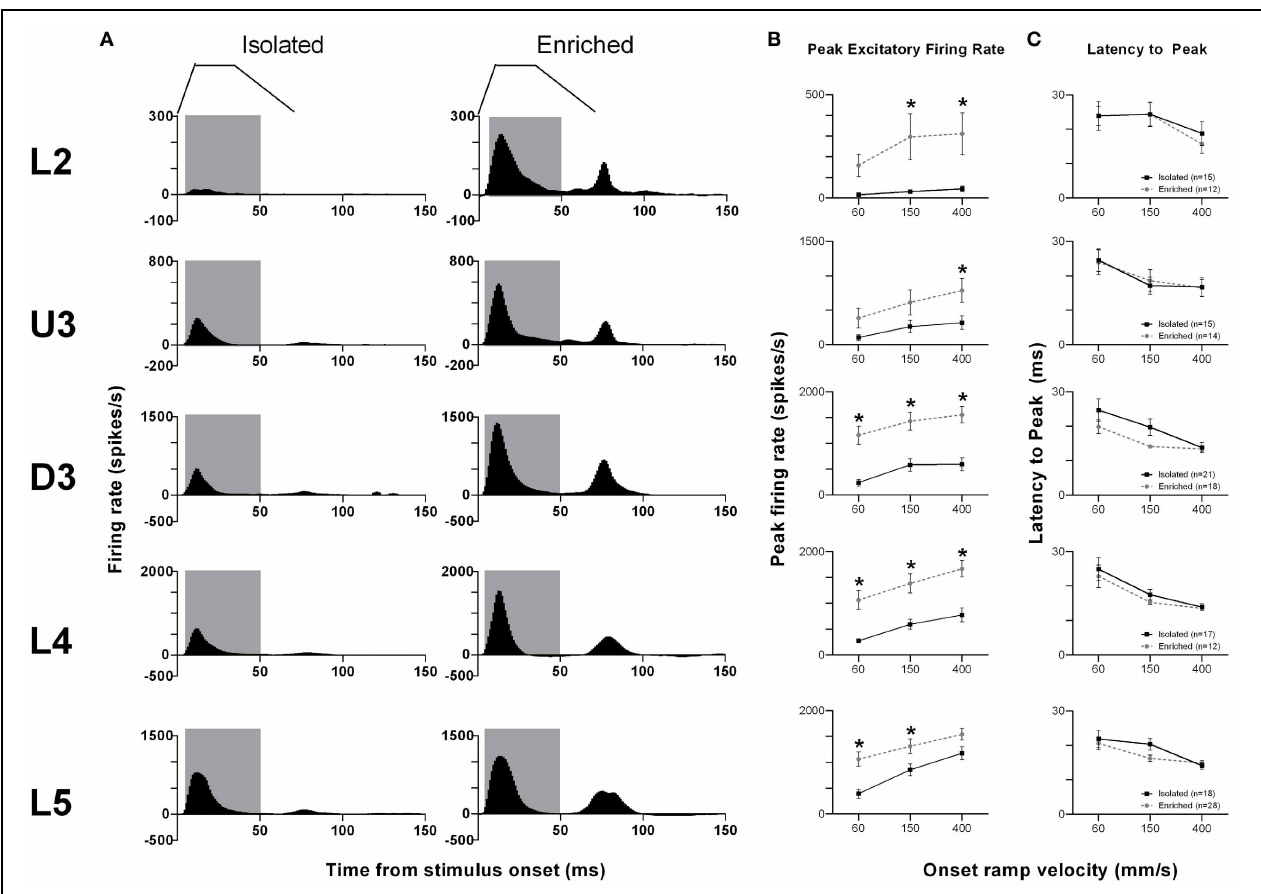
FIGURE 1 | EE effects on pattern, strength and timing of responses evoked by simple trapezoidal stimuli. For this simple stimulus, response strength significantly increased in all laminae after EE, with no changes in response timing. (A) Population Grand PSTHs in response to the trapezoid with the fastest onset ramp velocity (400mm/s) in a specific lamina (indicated to left of panel) in EE and Isolated animals. Laminar designations: L2, Layer 2; U3, Upper Layer 3; D3, Deep Layer 3; L4, Layer 4; L5, Layer 5. Each Grand PSTH was generated by averaging responses across all responsive clusters in that lamina. The analysis